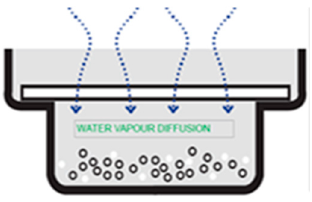
Figure 3. Diagram of dry cup test method [13].